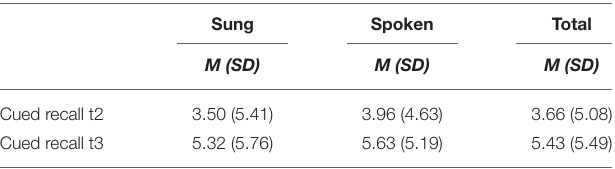
TABLE 3 | Performance cued recall of Song A (max. 21): means and standard deviations for both conditions and time-points. Sung